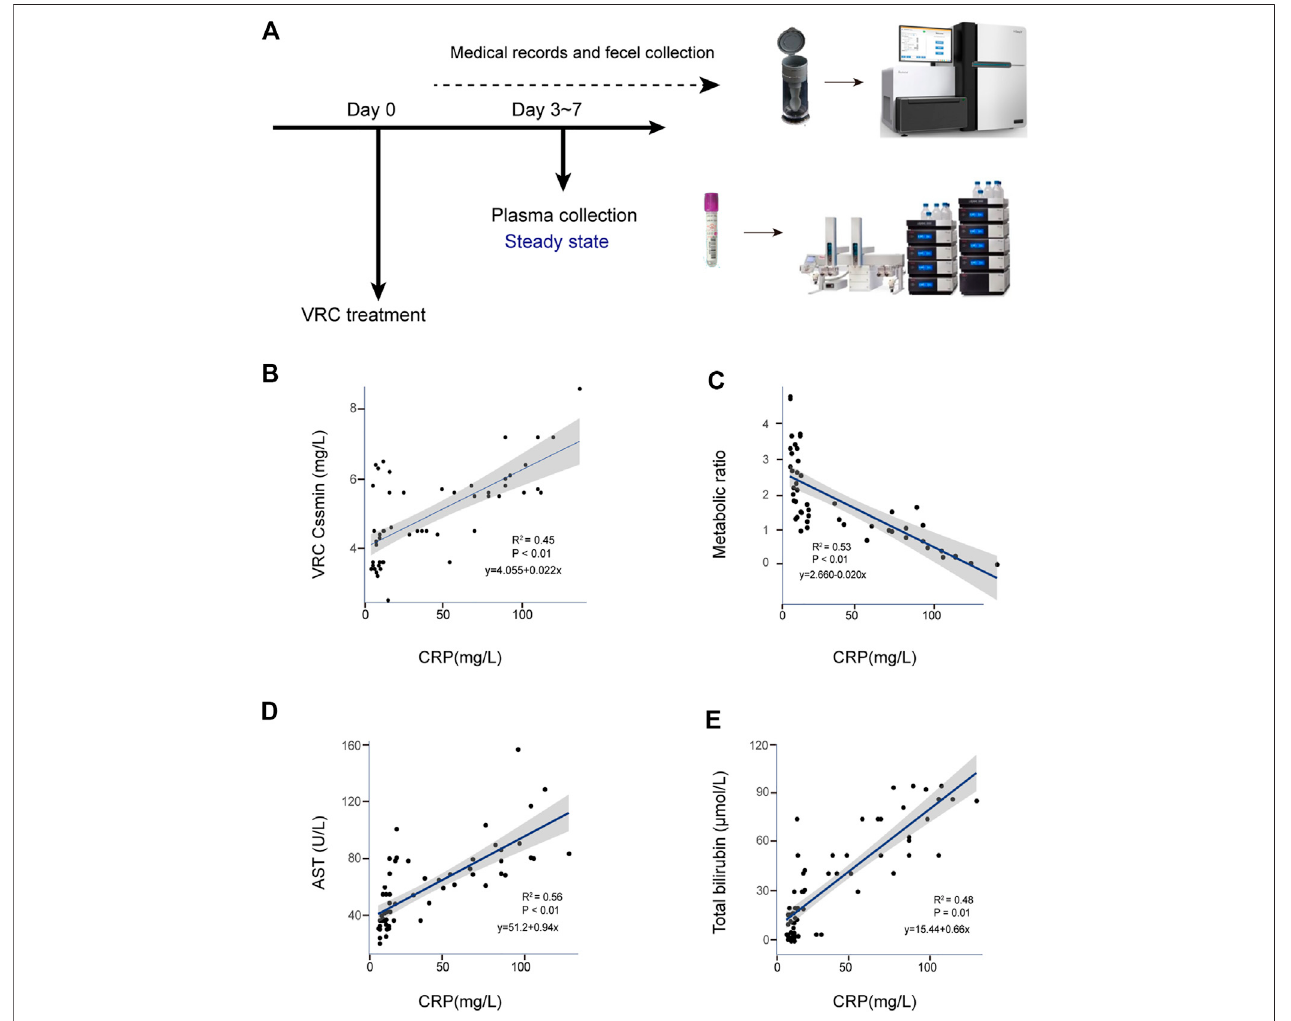
FIGURE 1 | Correlation between CRP and adverse reactions in clinical voriconazole administration. (A) Schematic of sample collection process. (B) Scatterplot of VRC Cssmin vs. CRPconcentration (mg/L). (C) Scatterplot ofVRC metabolic ability vs. CRPconcentration(mg/L). (D,E) Correlationbetweenthe CRPand liverfunction parameters possibly induced by voriconazole in peripheral blood. Each graph presents a trend line, regression equations, R-squared values (R 2 ) and p -values of the regression model are shown on the fi gures ( n (cid:1) 65).